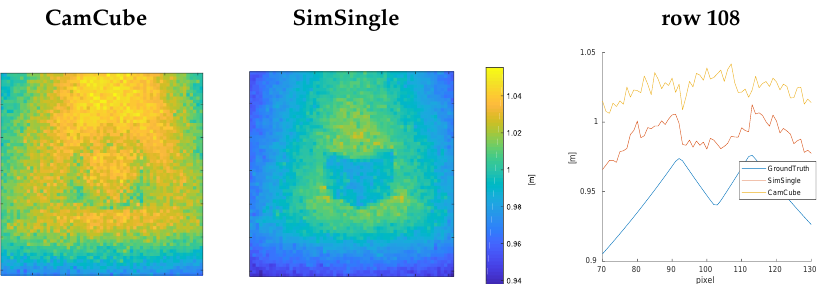
Figure 9. Evaluation of the corner scene with an aluminum cube (extraction of pixel regions [ 70,130 ] [ 70,130 ] ): this scene comprises a significantly larger amount of multipath effects that cannot be fully covered by our single-bounce simulation method.